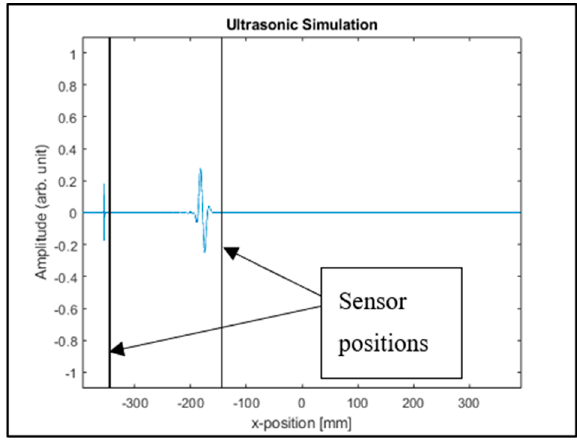
Figure 1. A-scan image of simulation.